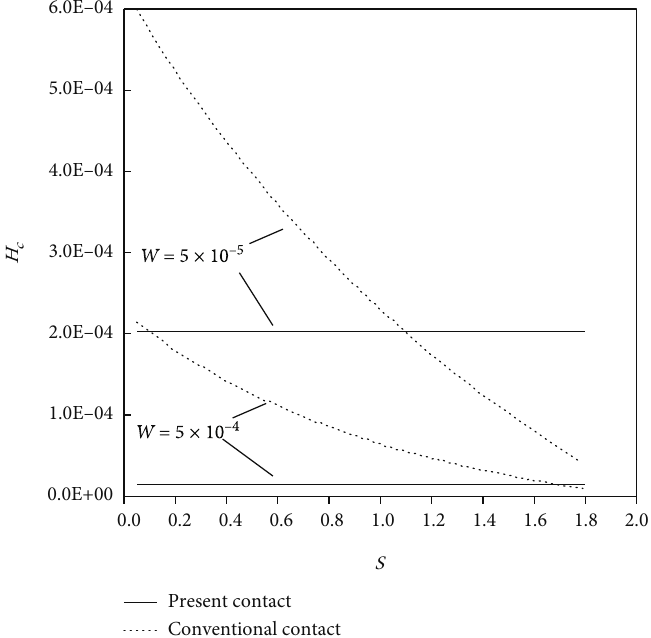
Figure 4: Comparison of the values of the dimensionless surface separations at the contact center, respectively, for the present line contact and the conventional line contact (without any wall slippage) for the same loads, U a = 1 × 10 − 9 and G = 4500 . Slide-roll ratio: S = 2 ð u a − Þ / ð u u Þ u b a + b